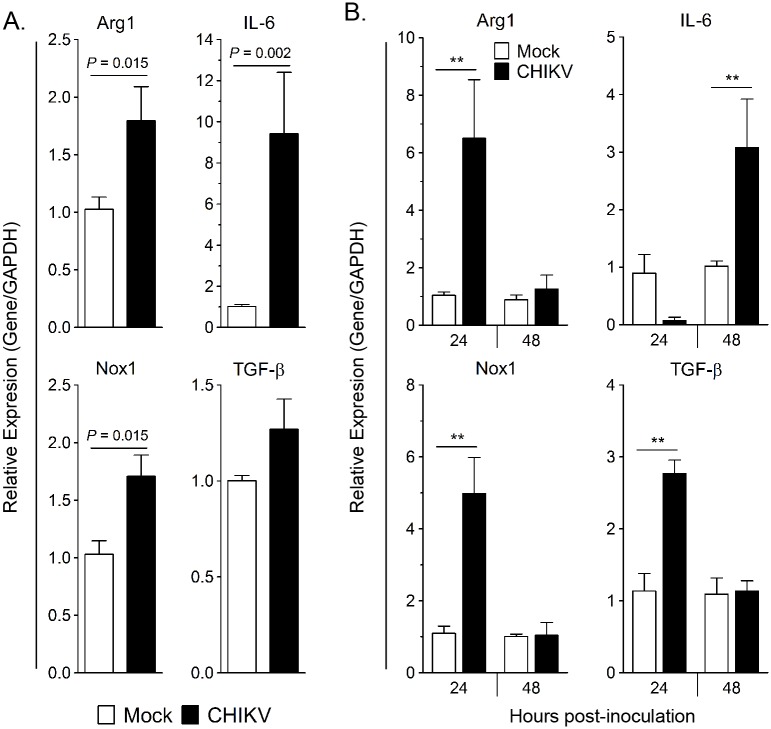
CHIKV-infected HS 633T fibroblast co-culture and supernatant induces Arg1 expression in human monocytes.(A) CHIKV adsorption (MOI 10) on HS 633T cells was performed for 1.5 h before virus overlay was removed; human monocytes were then co-cultured with the HS 633T cells for 24h. The level of gene expression was expressed as fold change compared to monocytes co-cultured with mock-infected cells after normalization to GAPDH. Experiments were performed in triplicate and data are mean ± SEM of two independent donors. Pair-wise comparison was performed using a two-tailed Mann Whitney U test. (B) HS 633T cells were infected with CHIKV (MOI 10) for 24h and 48h. Cell-free supernatant were collected and overlaid onto human monocytes for 24h. The level of gene expression was expressed as fold change compared to monocytes inoculated with cell-free supernatant from mock-infected cell lines after normalization to GAPDH. Experiments were performed in triplicate, and data are represented as mean ± SEM of two independent donors. Pair-wise comparison was performed using two-tailed Mann Whitney U test (** P < 0.01).